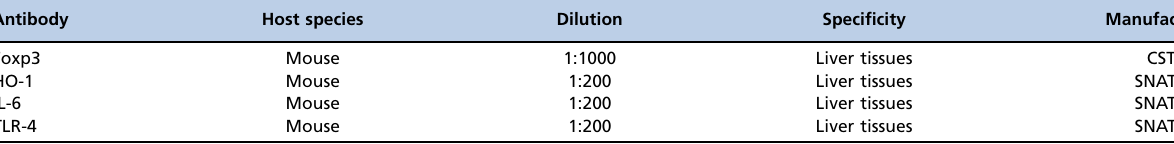
Table 2 - Antibodies used for western blotting.